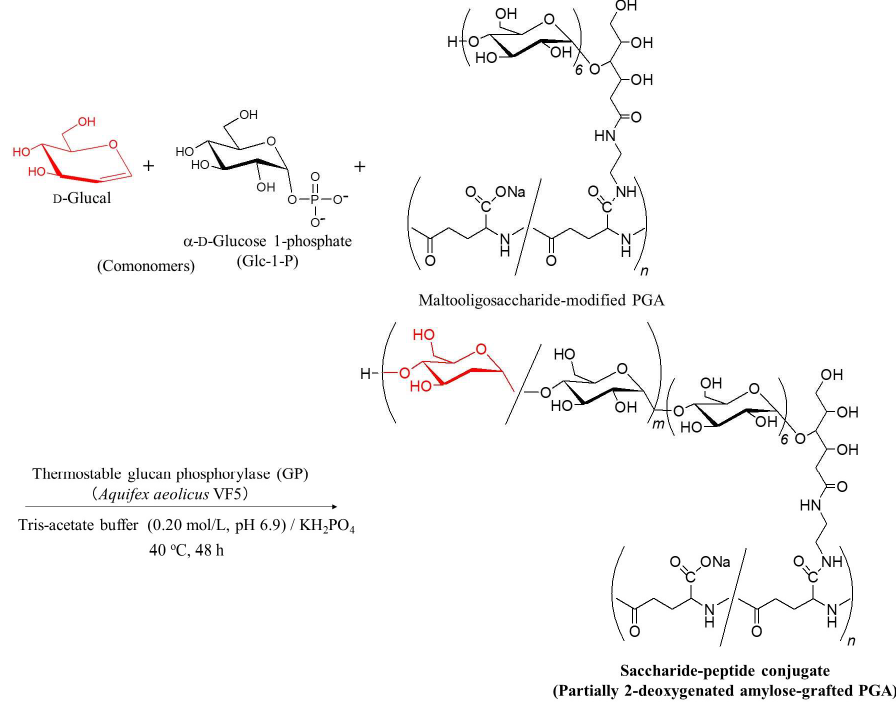
Figure 2. Thermostable GP-catalyzed copolymerization of D -glucal with Glc-1-P (comonomers) from PGA to produce partially 2-deoxygenated (P2D)-amylose-grafted PGA.